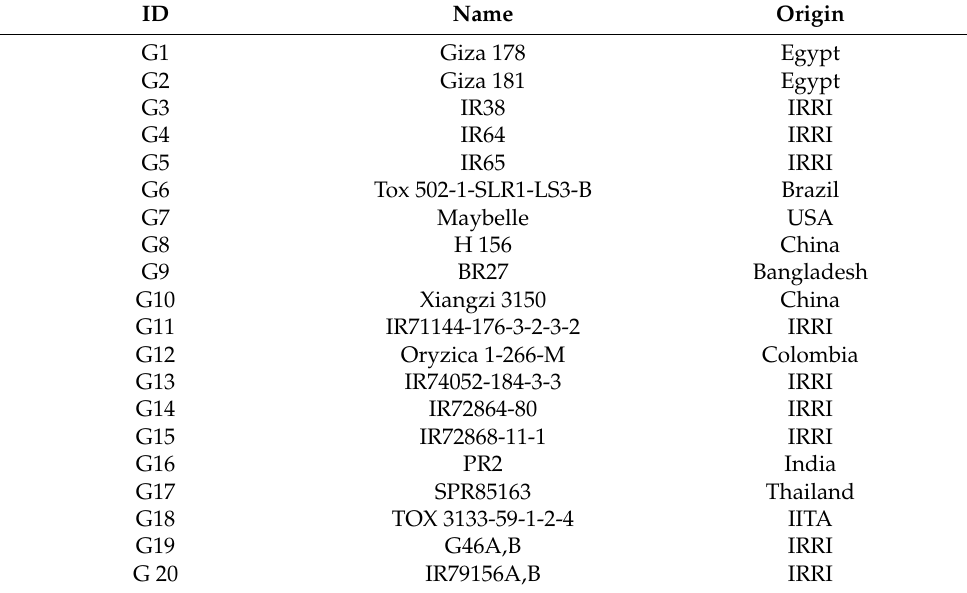
Table 1. List of rice genotypes used in this